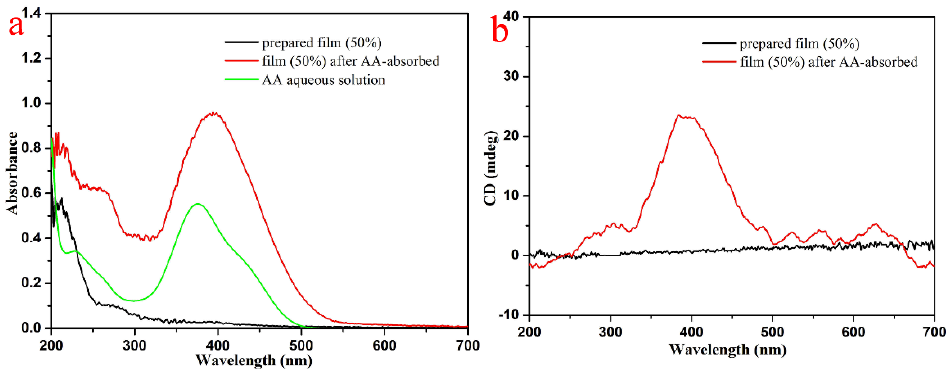
Figure 8. UV – VIS ( a ) and circular dichroism spectra ( b ) of the PCL/(50%)PCD composite fibers.